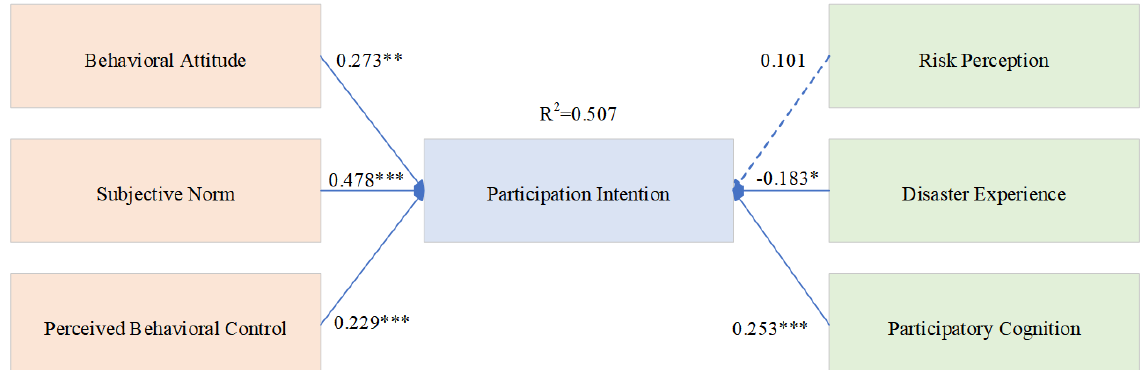
Figure 3. Expanding the TPB model results ( ∗ p< 0 . 05, ∗∗ p< 0 . 01, ∗∗∗ p< 0 . 001; the solid line is the significant path, but the dotted line is